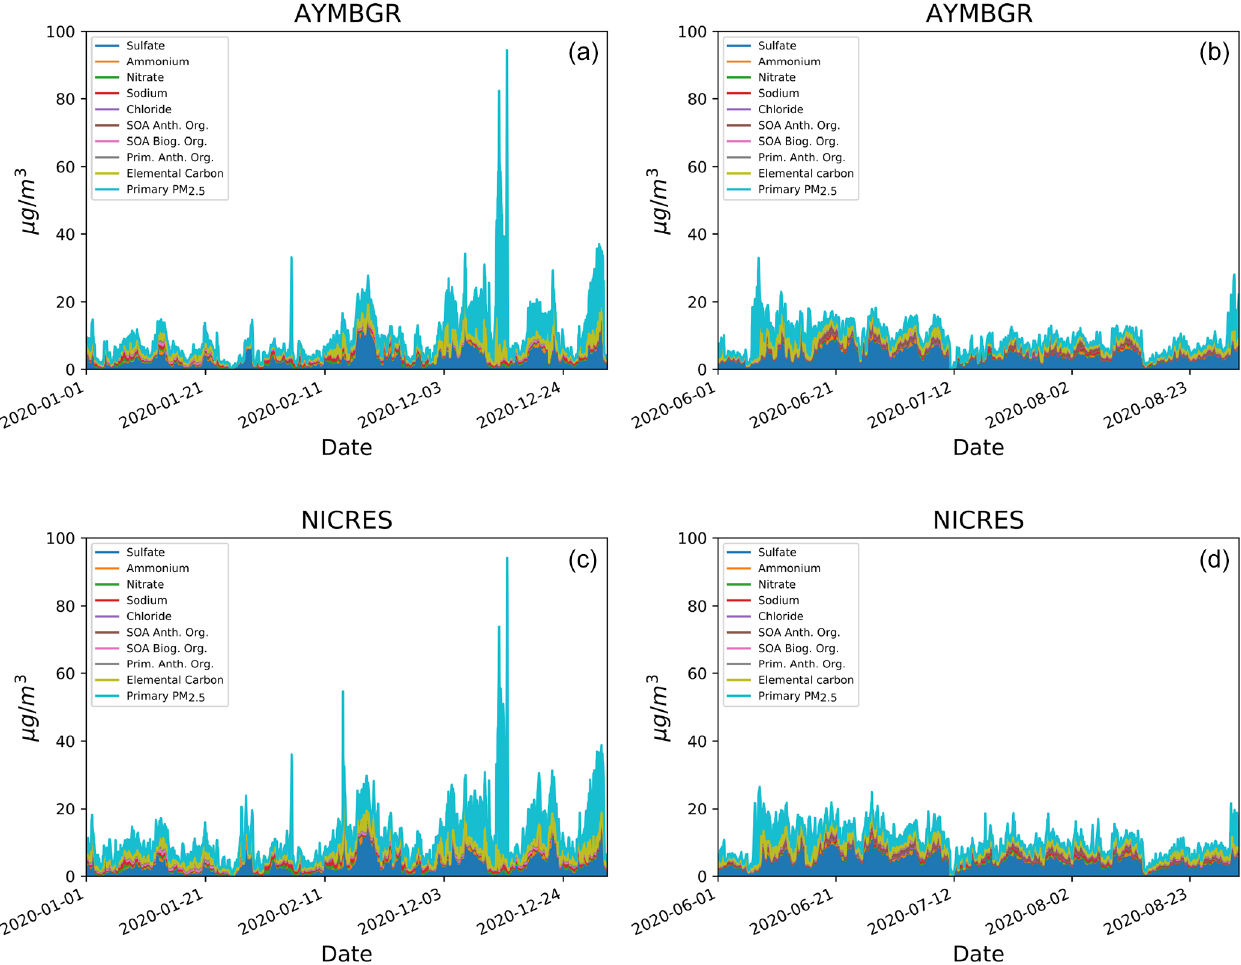
Figure 9. Hourly concentrations of the PM 2 . 5 subcomponents and their contribution to the total PM 2 . 5 concentrations at the Ayia Marina background station (a, b) and the Nicosia residential station (c, d) for winter (a, c) and summer (b, d)